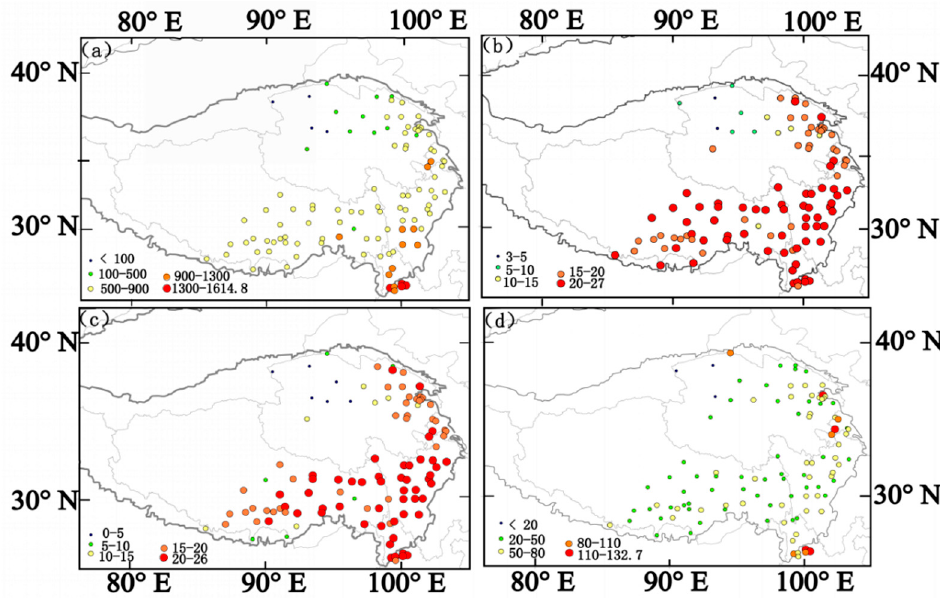
Figure 2. Characteristics of precipitation and extreme precipitation over the Tibetan Plateau from 1981 to 2016: ( a ) extreme precipitation (unit: mm); ( b ) extreme precipitation frequency; ( c ) extreme precipitation frequency greater than 25 mm; ( d ) Daily maximum precipitation (unit: mm).